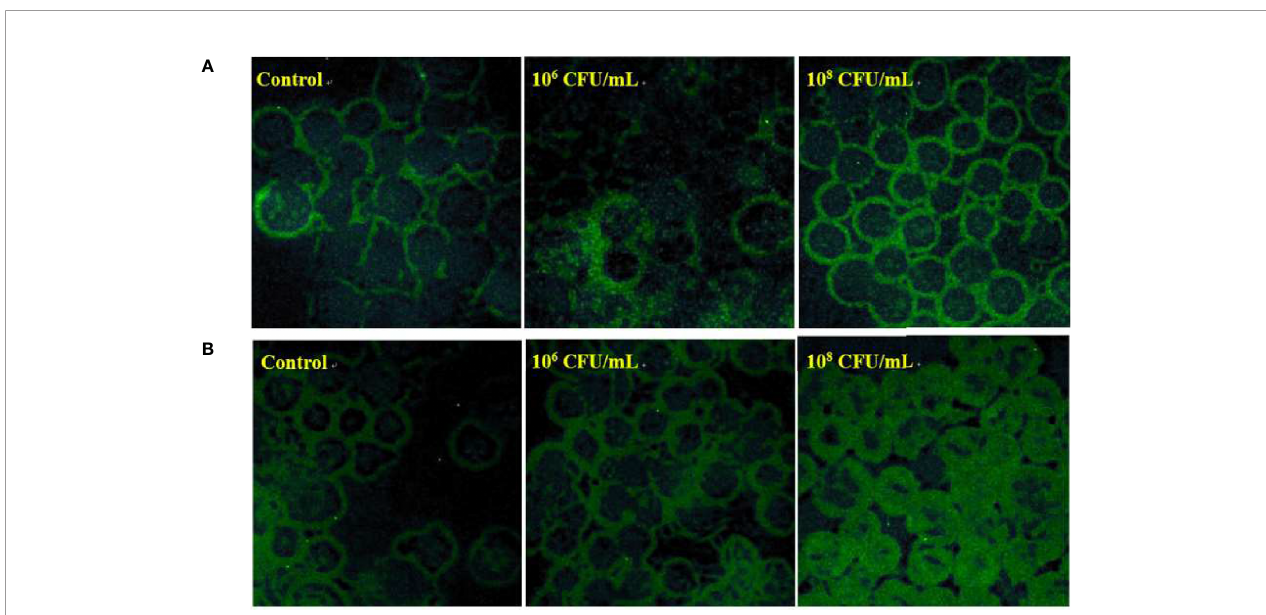
FIGURE 4 | C. butyricum increases the glycoprotein and mucus pro fi les of HT-29 cells. n=3. (A) After pre-treatment with C. butyricum for 6h, HT-29 cells were stained with FITC labeled UEA. (B) After pre-treatment with C. butyricum for 6h, HT-29 cells were stained with FITC labeled WGA.